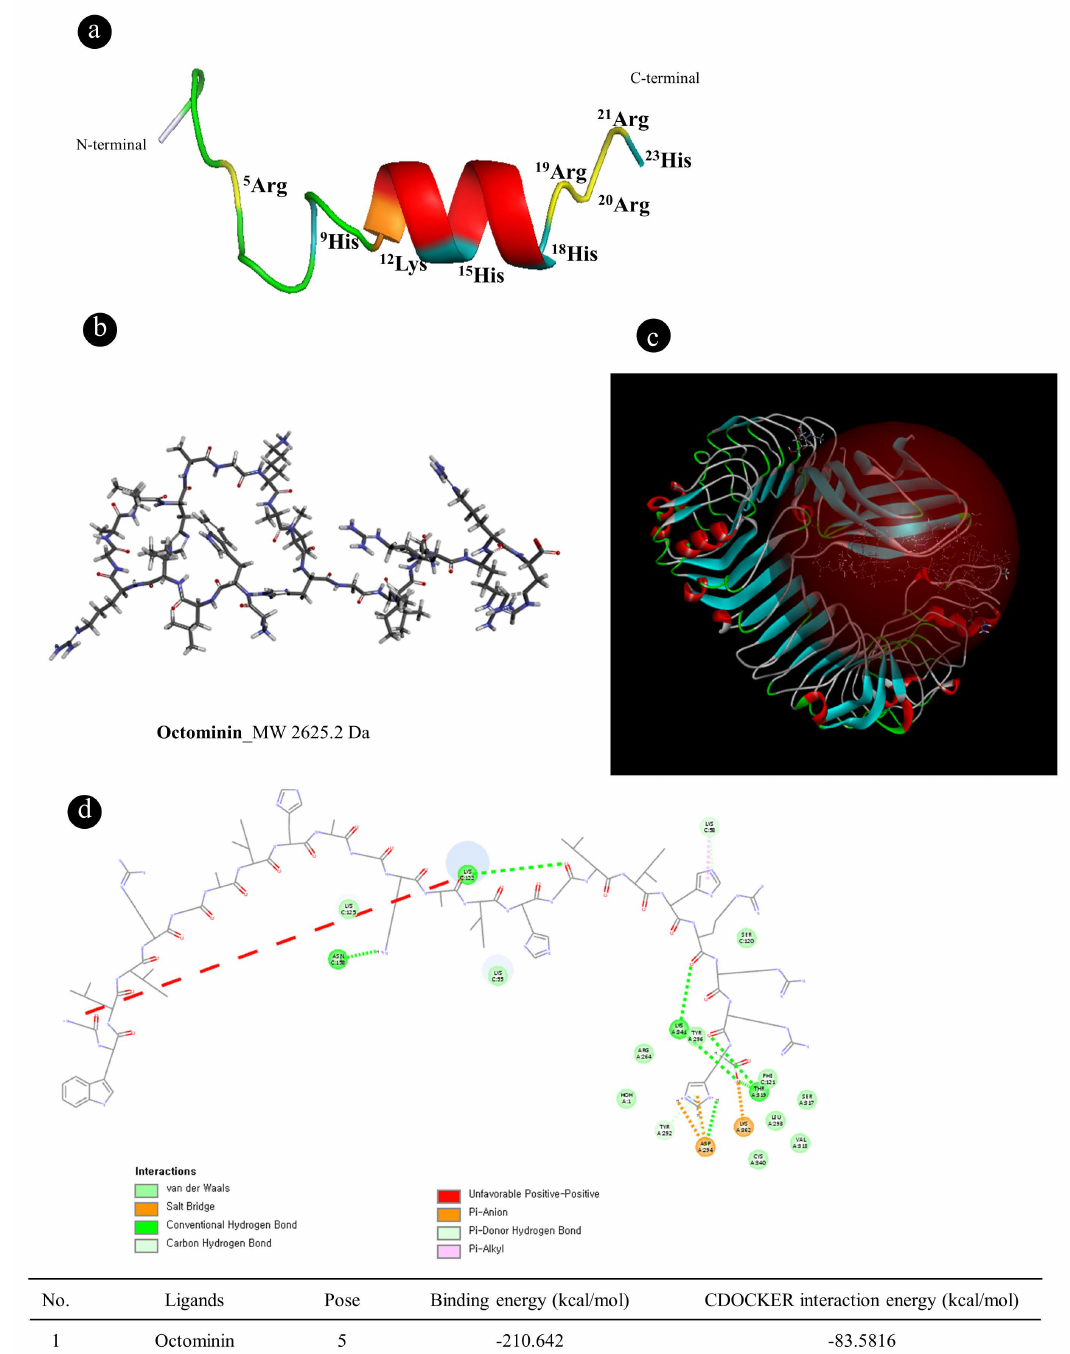
Figure 1. Molecular docking of Octominin to the Toll-like receptor 4 (TLR4) / myeloid di ff erentiation factor 2 (MD-2) complex. ( a ) Three-dimensional (3D) structures of the amino acid sequence of Octominin. Adopted from Nikapitiya et al. (2020); ( b ) Two-dimensional (2D) diagram of Octominin (The most hydrophobic residue is green, and the amount of green is decreasing proportionally to the hydrophobicity, with zero hydrophobicity coded as yellow); ( c ) Predicted Octominin binding site to the crystal structure of the TLR4 / MD-2 complex; and ( d ) amino acid binding cites of Octominin with TLR4 /